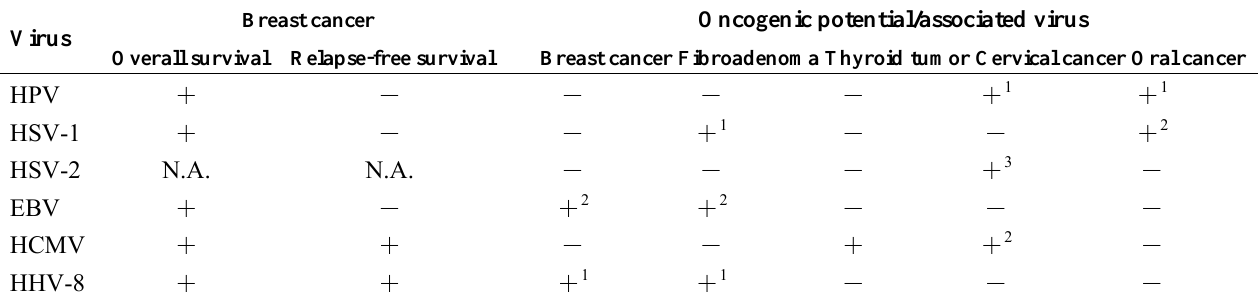
Table 2. Summary of the significance of viral factor to the overall survival, relapse-free survival and oncogenic potential/associated virus of breast cancer, fibroadenoma, thyroid tumor, cervical cancer, and oral cancer patients. ＋ : significant; － : not significant. N.A.: not available. The Arabic number represents the order of significance.